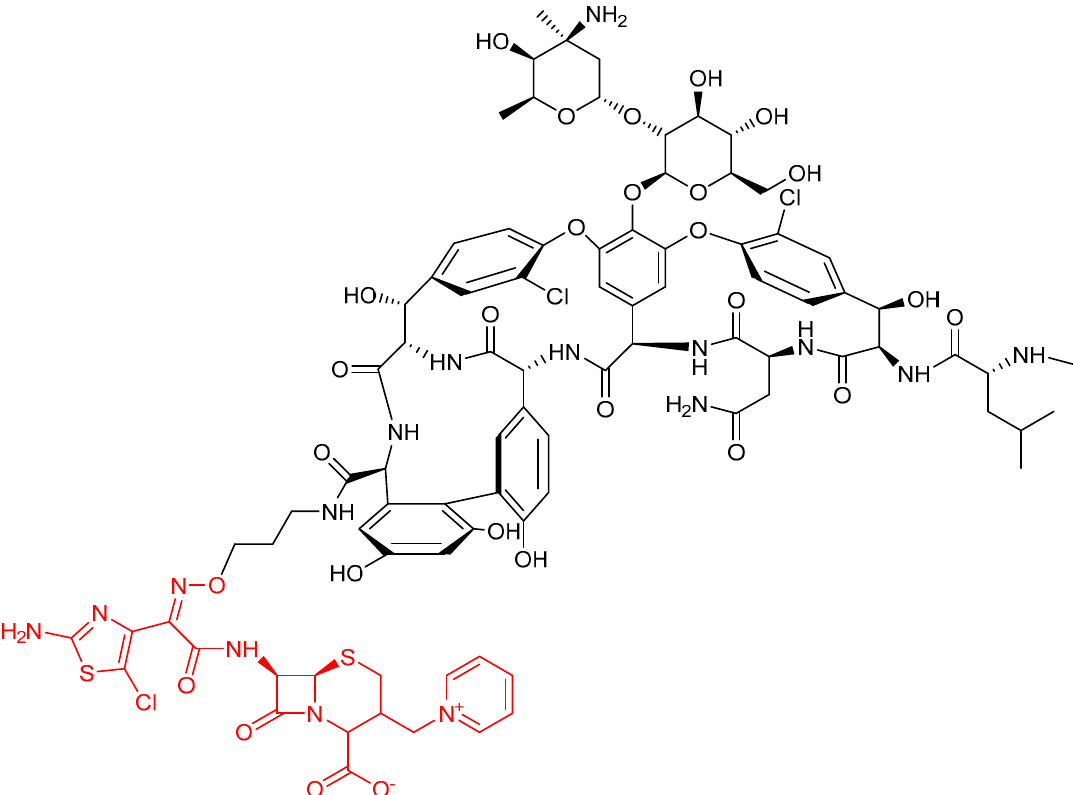
Figure 11. Chemical structure of compound TD-1792. The cephalosporin moiety is highlighted in red.